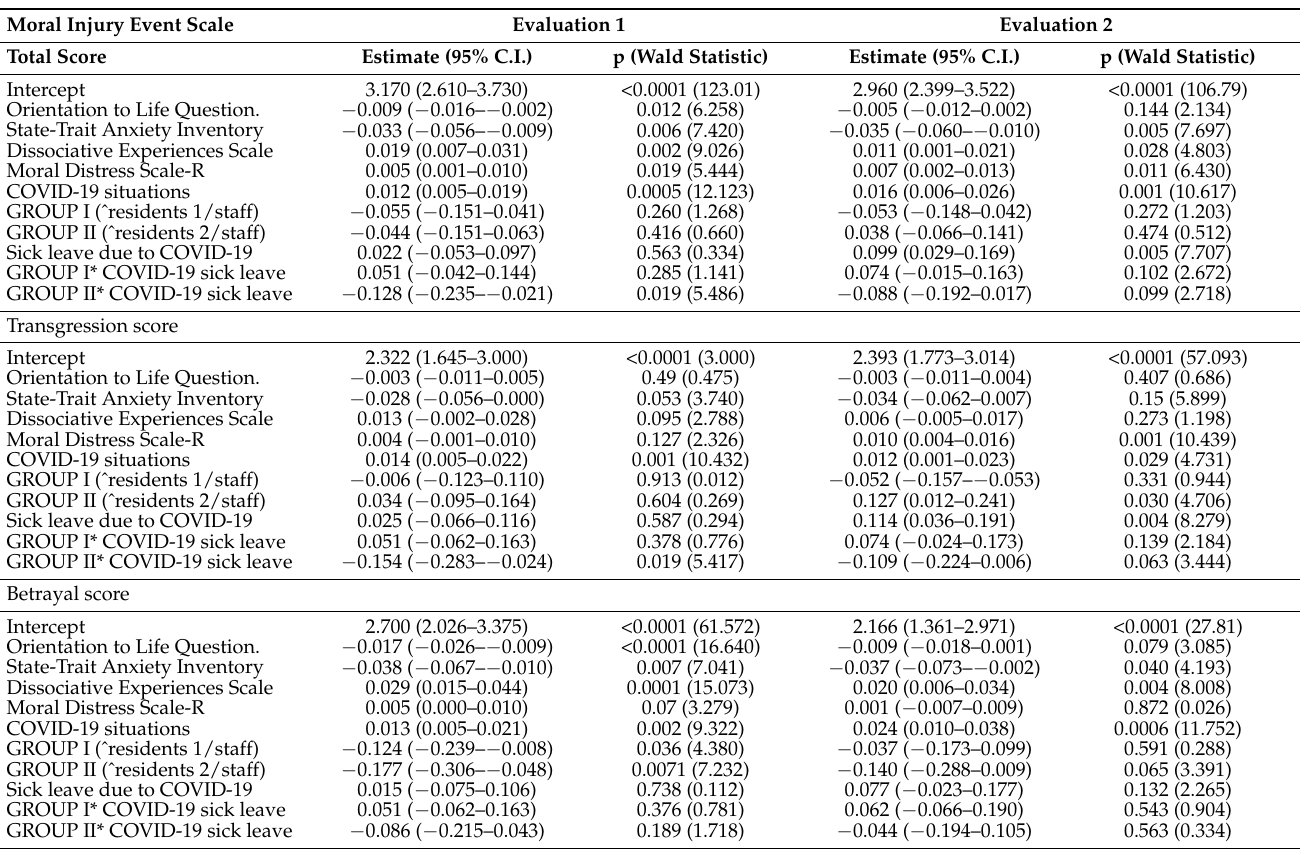
Table 6. Results of the multivariable analysis on the score and sub-scores on the Moral Injury Event Scale of 108 physicians, in the two